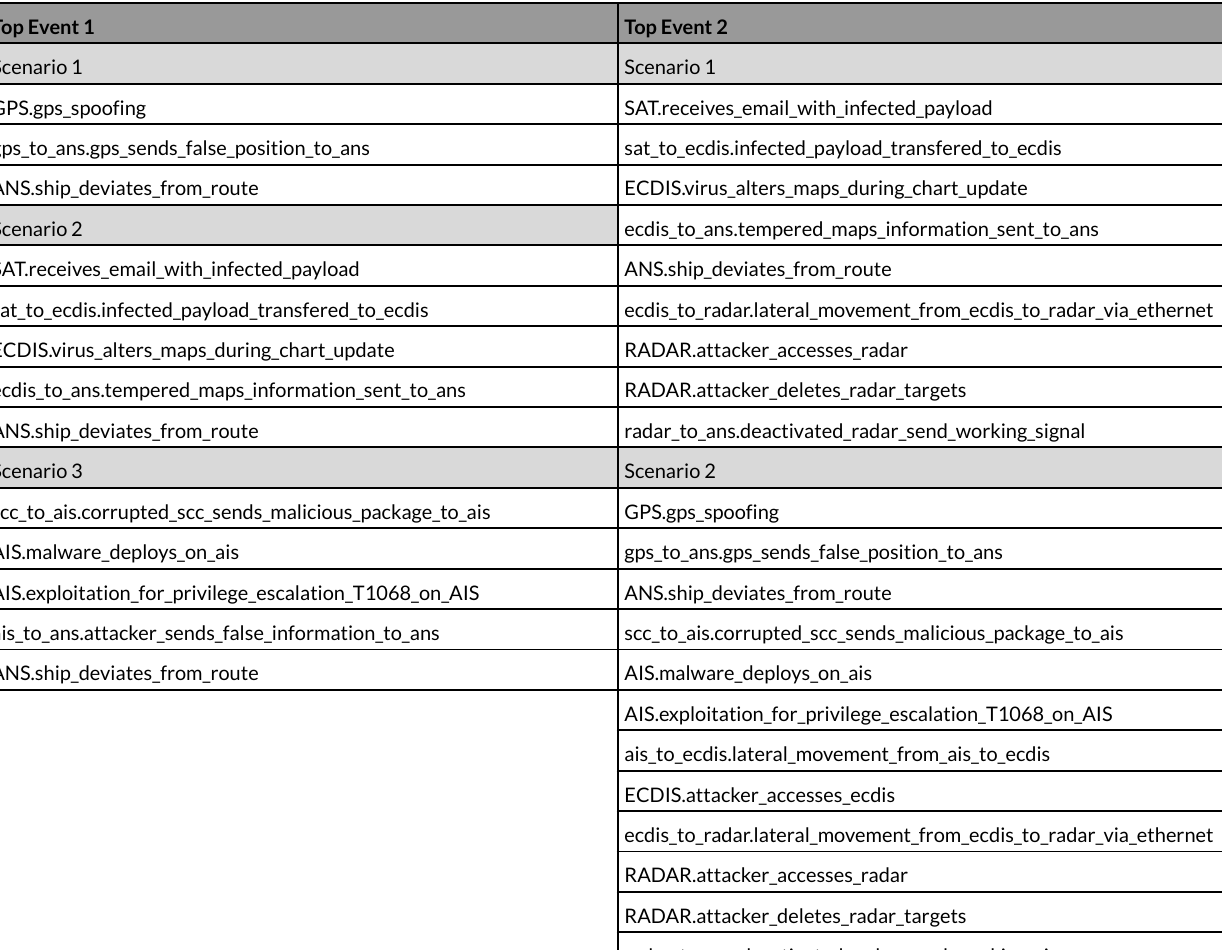
Figure 3. Example of Scenarios for Top Events 1 and